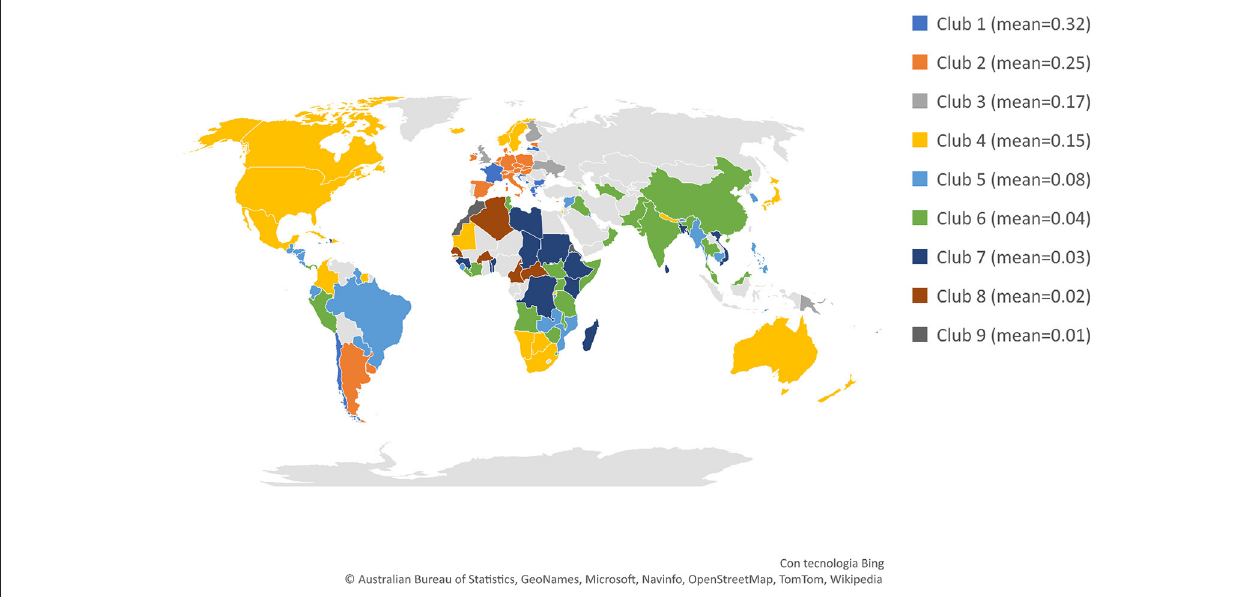
FIGURE 3 | Final clubs (Female. Set B - Countries with decreasing smoking rates, 1990–2019). Countries in light gray are included in the sample with increasing smoking rates or are countries with no